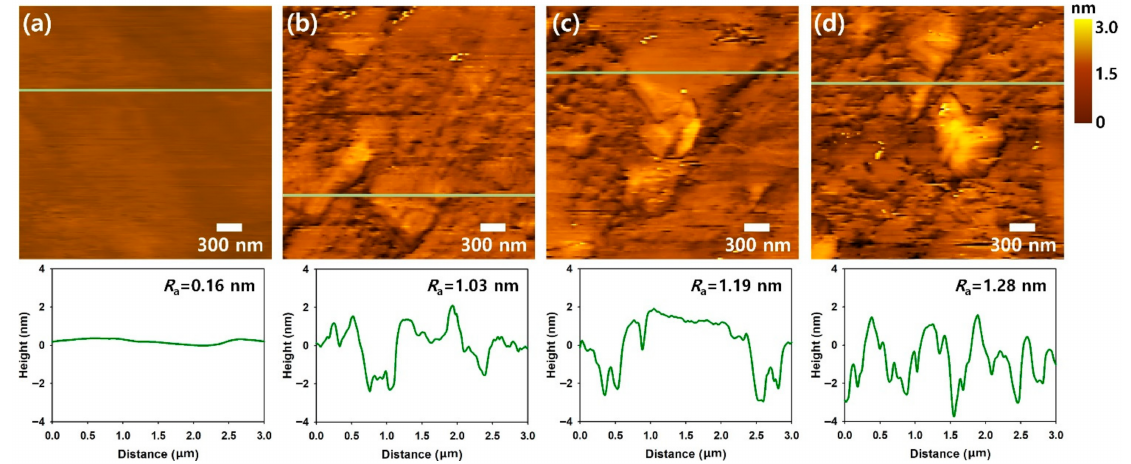
Figure 1. Overall procedures for crystallization of polyketones (PKs) on the plasma-treated graphene sheets.